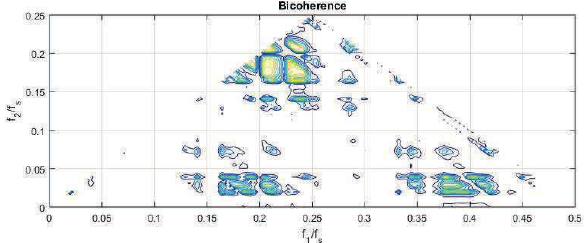
Fig. 7: Bicoherence of the state x of Fractional order System (16).